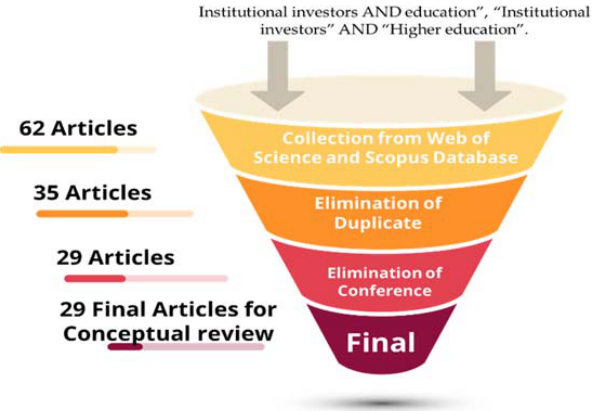
Figure 1. Flow Diagram of Article Selection for Conceptual Review.